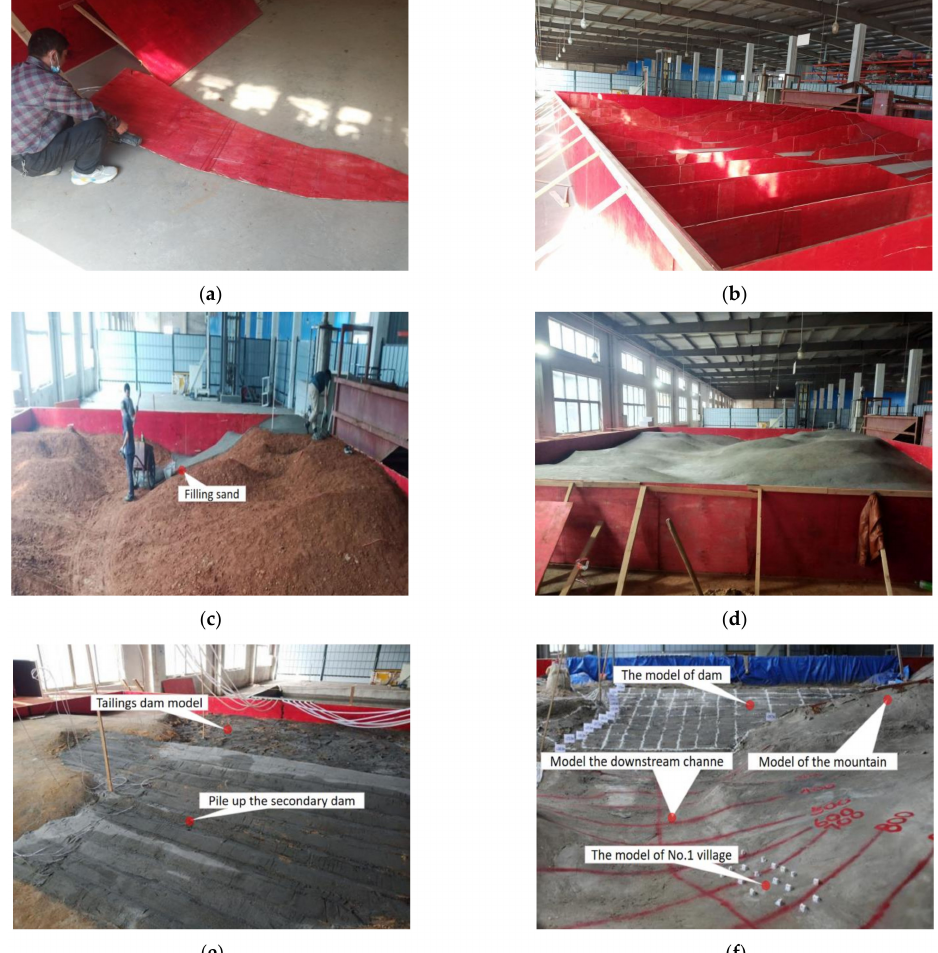
Figure 2. Indoor test modeling. ( a ) Cut off panel. ( b ) Standing plate. ( c ) Fill sandy soil. ( d ) Conservation. ( e ) Stacking of sub-dams. ( f ) Final model.